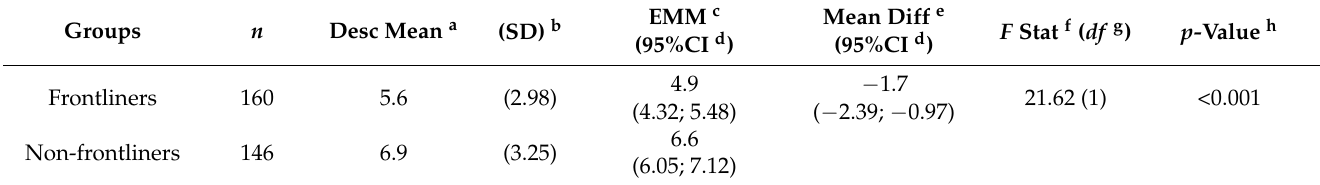
Table 3. Comparison of frontline and non-frontline healthcare providers’ anxiety